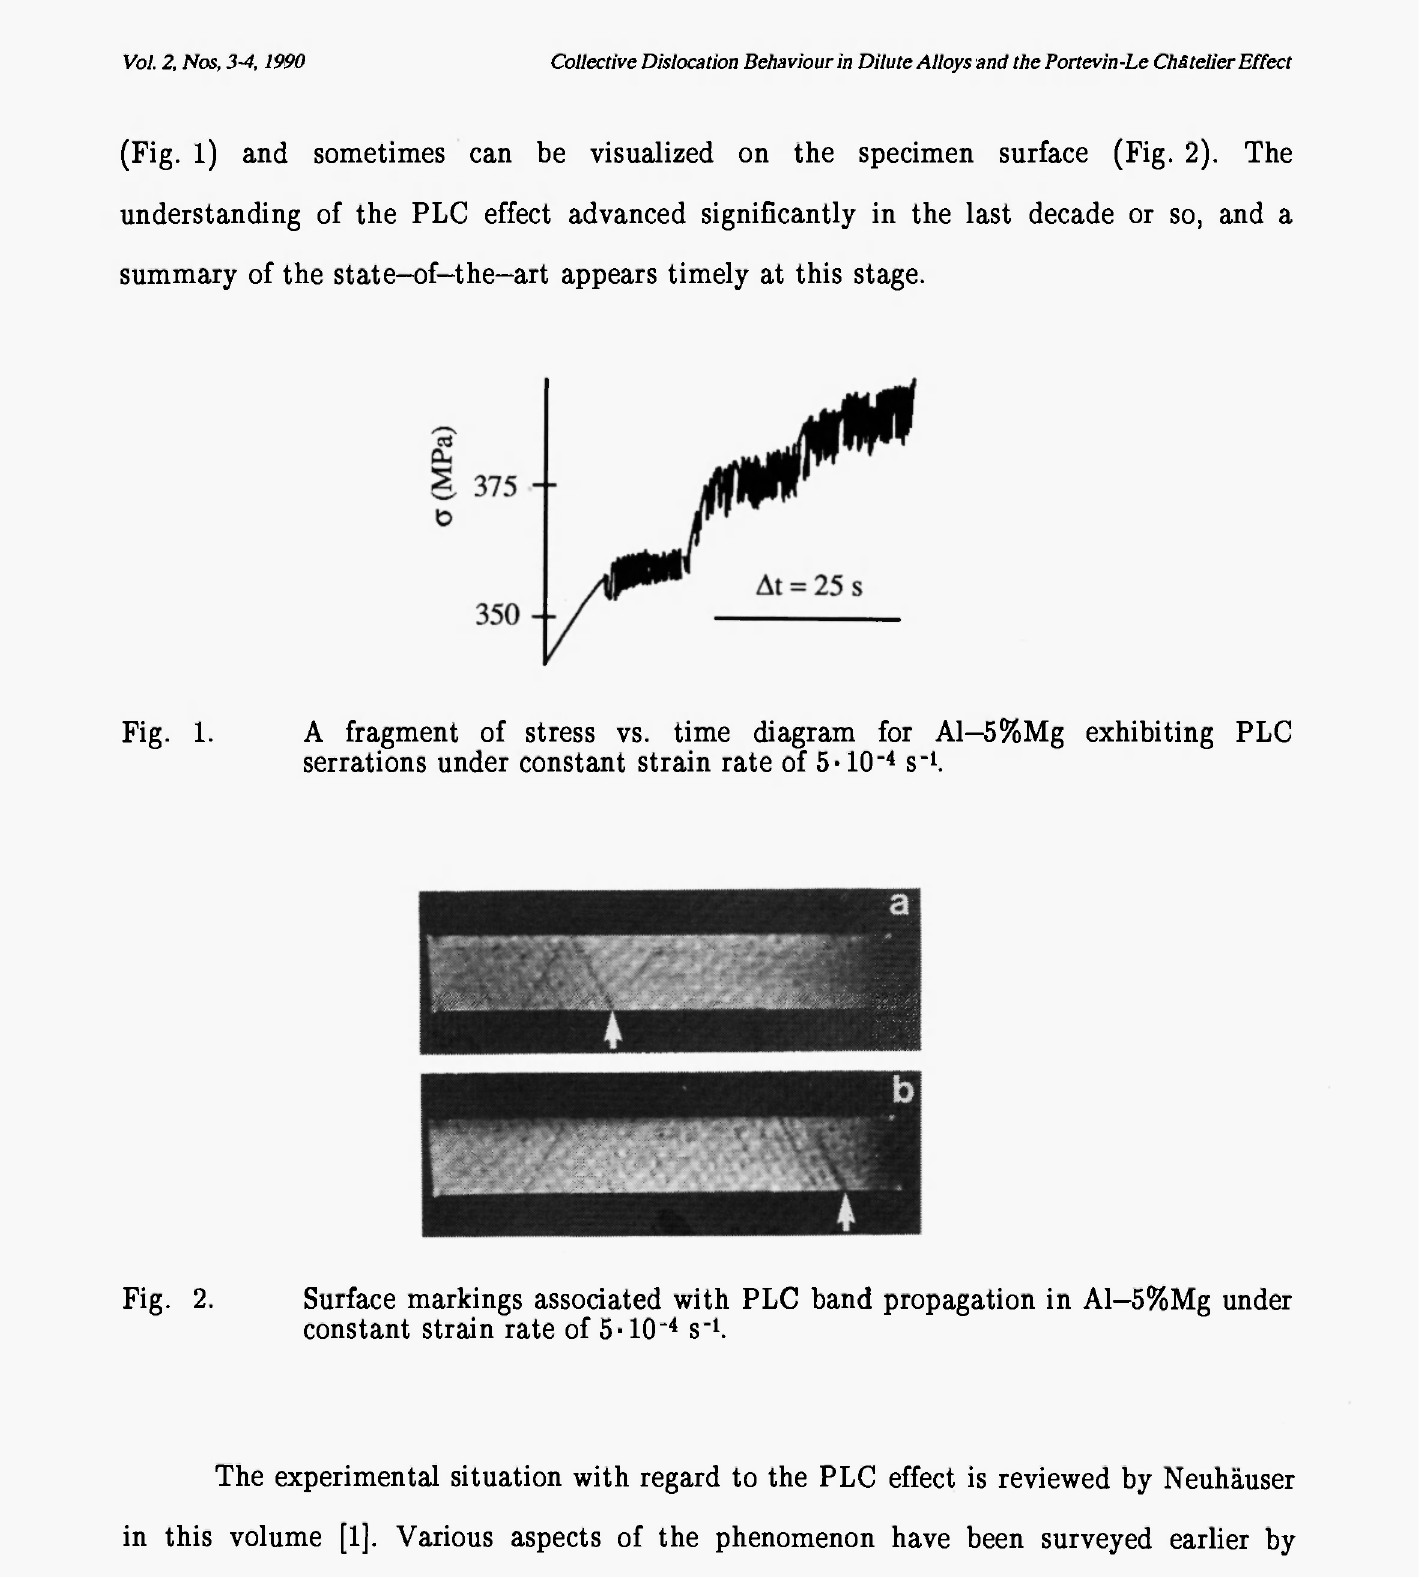
Fig. 1. A fragment of stress vs. time diagram for Al—5%Mg exhibiting PLC serrations under constant strain rate of 5·10~ 4 s" 1 .